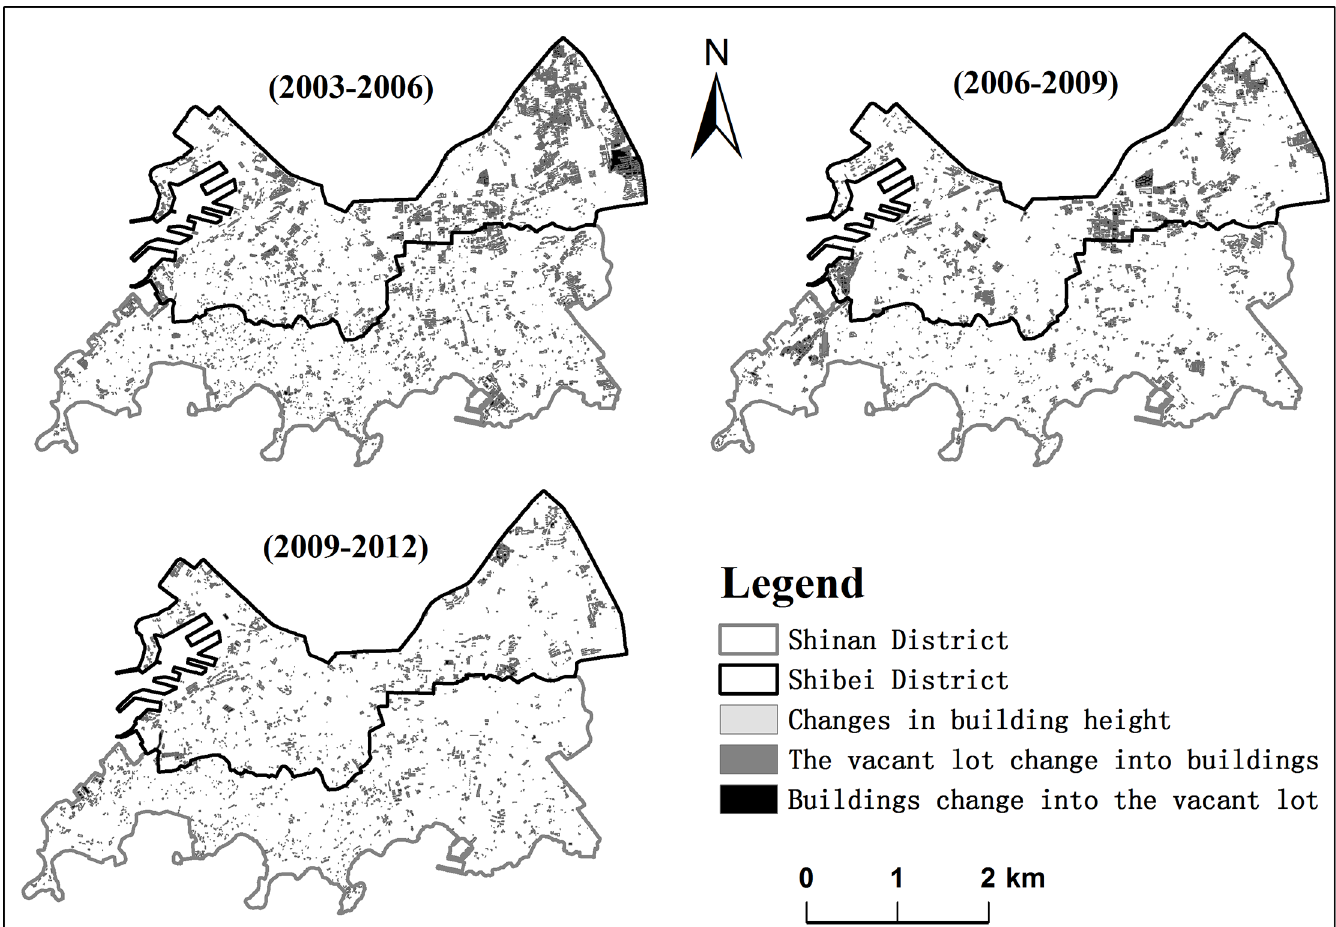
Fig 3. Spatiotemporal distribution of the changed buildings from 2003 to 2012.